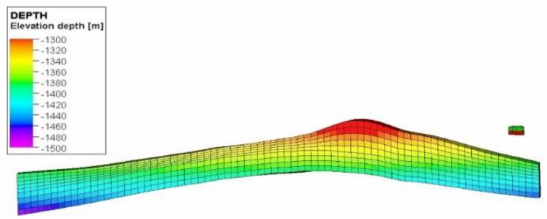
Figure 5. Vertical cross section of the reservoir simulation model along line A–A’.